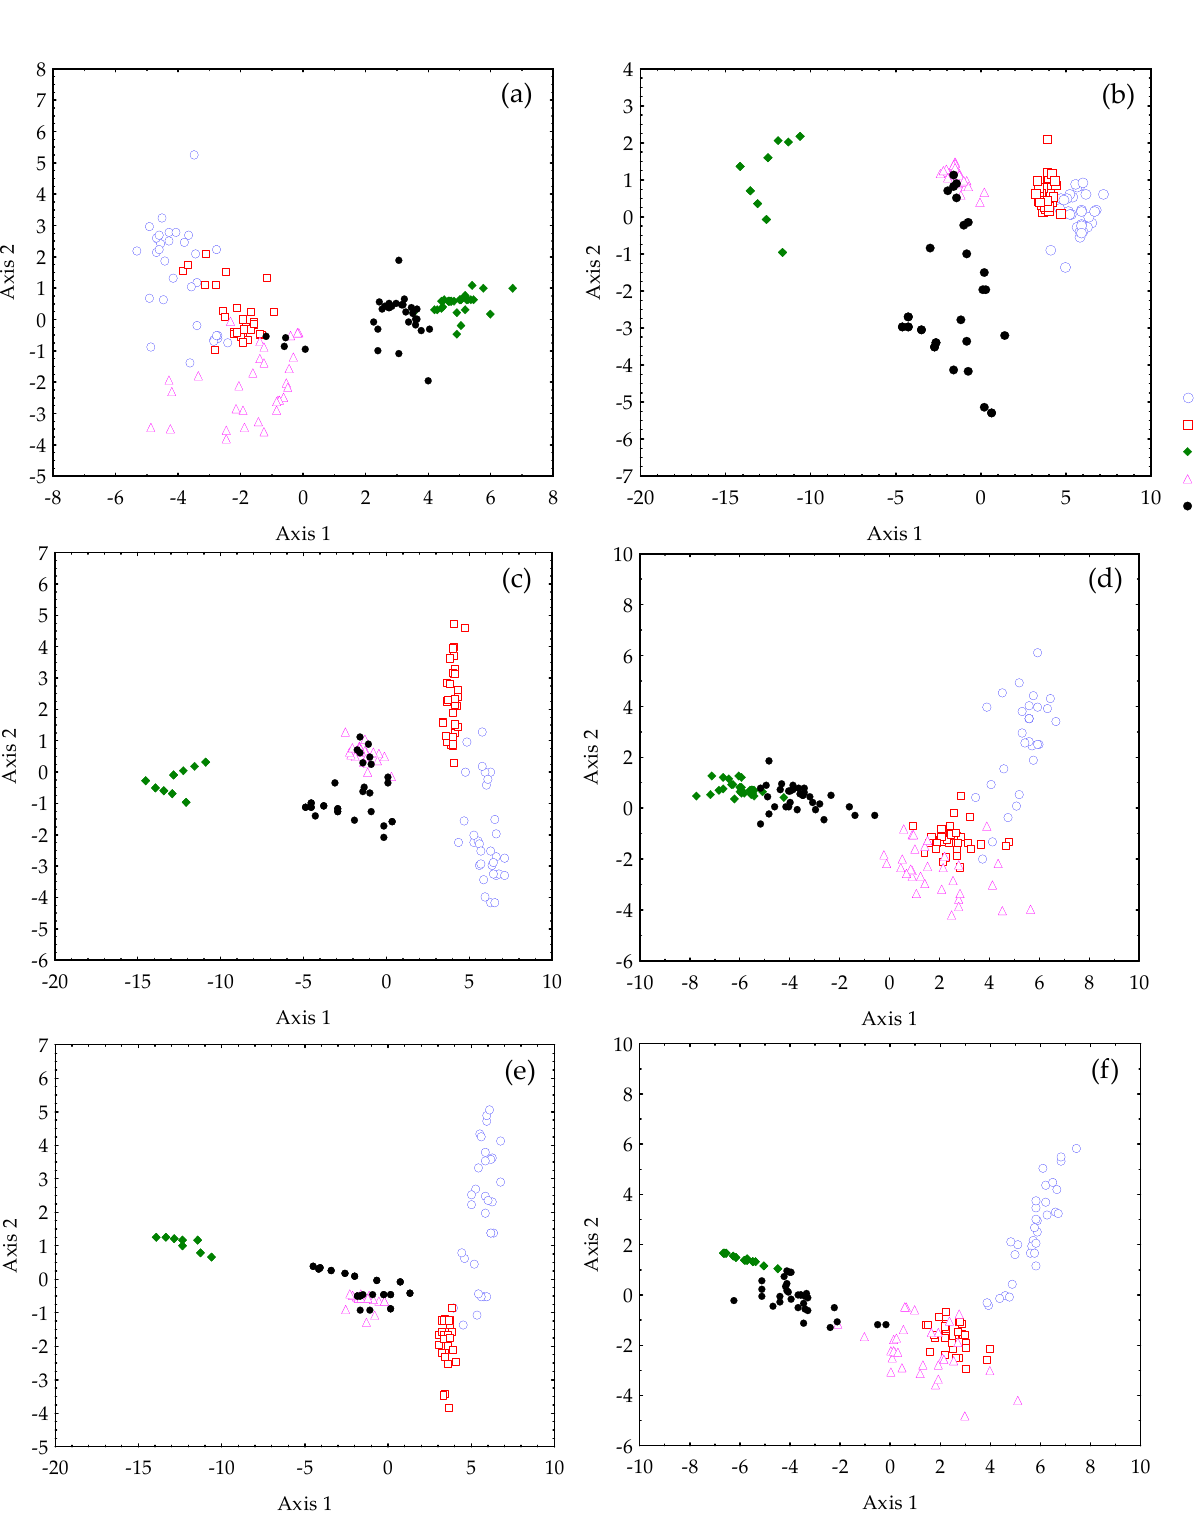
Figure 6. Discriminant analysis based on the abundance of different taxa and different seasons in relation to the temperature and relative humidity in the Sierra de Juárez, Oaxaca, Mexico. Axes 1 and 2. ( a ) families “nortes”, ( b ) families rains, ( c ) genera “nortes”, ( d ) genera rains, ( e ) species “nortes”, ( f ) species